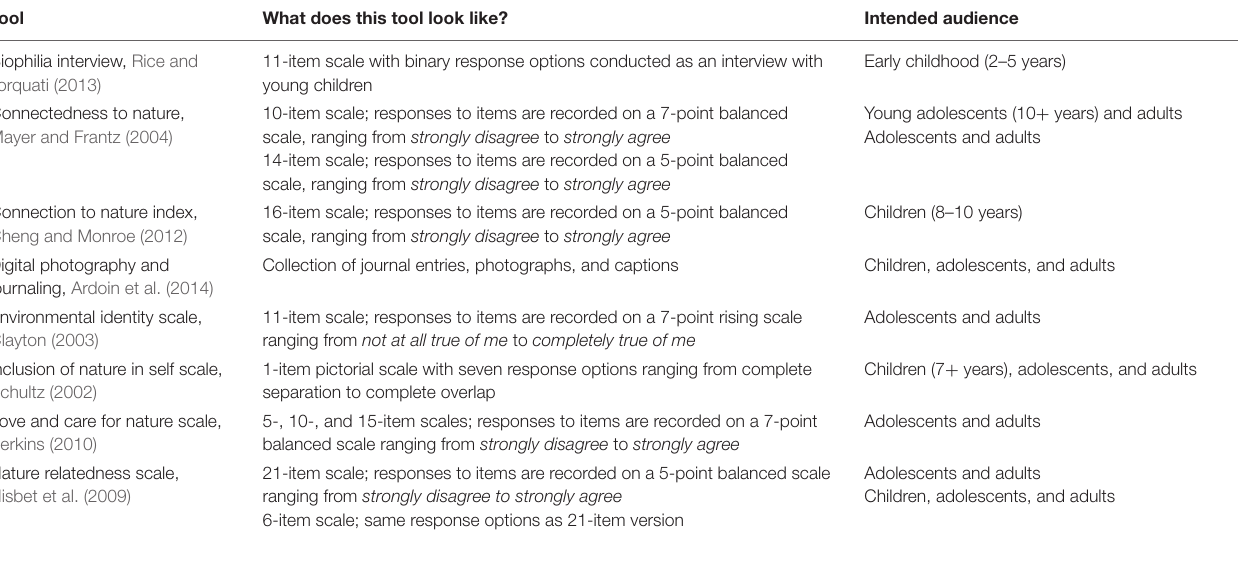
TABLE 1 | Tools identified as being useful to practitioners to assess connection to